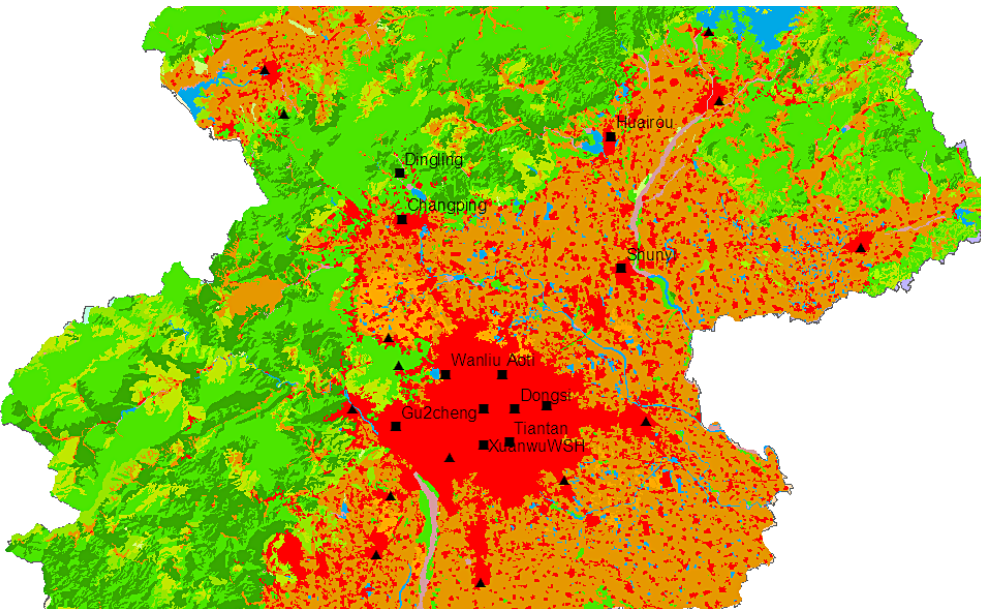
Figure 5. Map of the stations of Beijing MEMC air quality monitoring network. Black shows the location of each observation station – squares are the National Standard Air Quality Observation Stations (NSAQ Stations) and triangles are the other air quality observation stations in the monitoring network. The shading indicates land use: red shading indicates urban area, dark green indicates forest, light green indicates grass, orange indicates crop, blue indicates